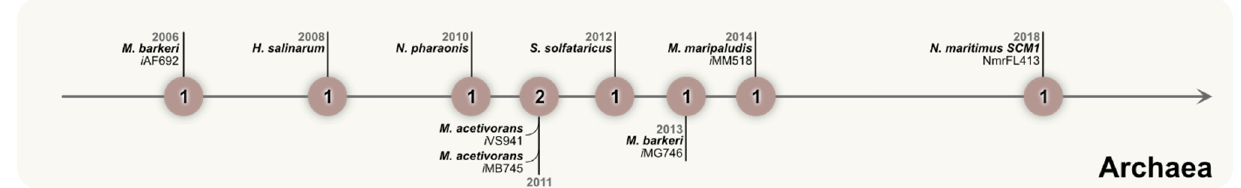
Figure 4. Available models for Archaea. The nodes in brown represent the year of GEM reconstruc- tion and number of GEMs reconstructed for archaea (Supplementary File S3).